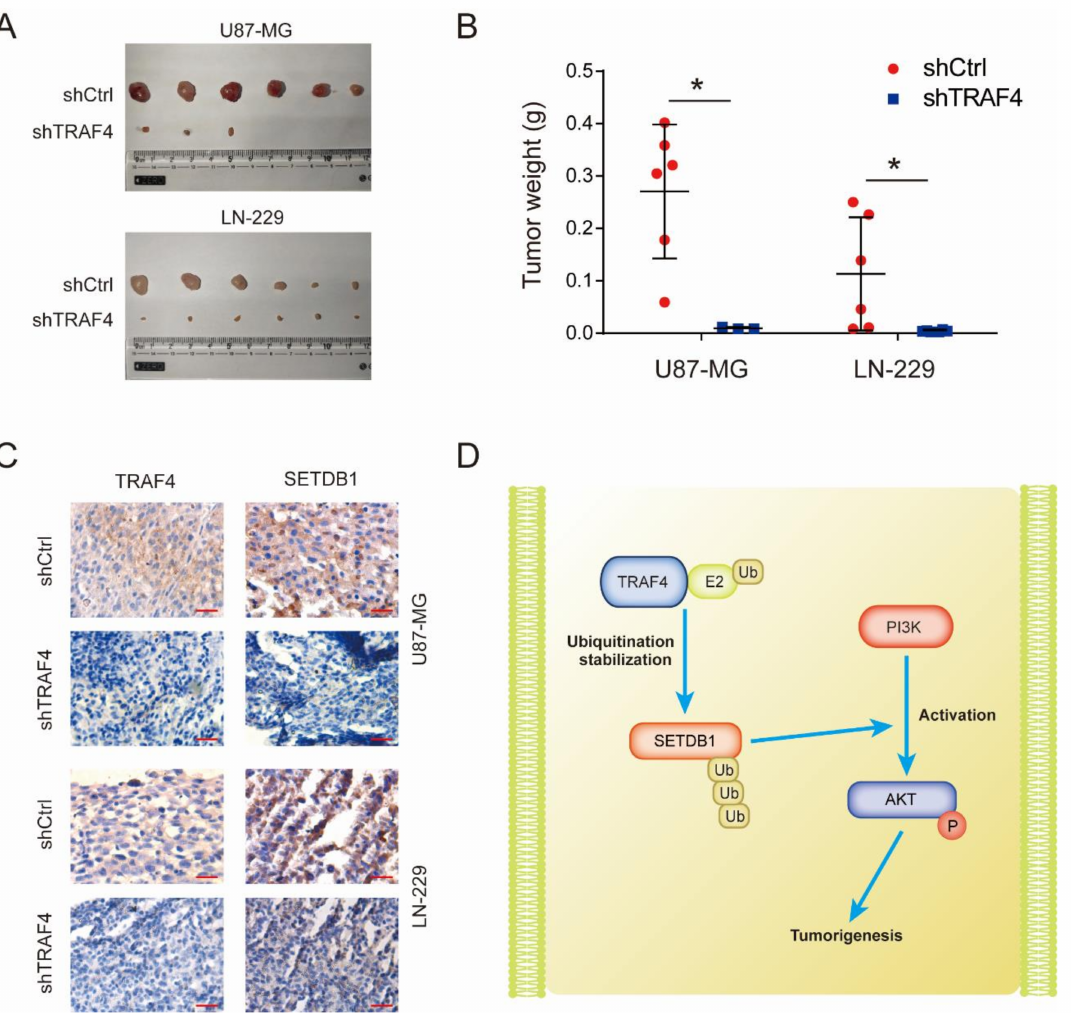
Figure 8. Knockdown of TRAF4 inhibits tumor formation of glioblastoma cells in vivo. ( A ) The in vivo tumorigenic ability of glioblastoma cells was detected by xenograft assay in mice following TRAF4 knockdown. ( B ) Tumor tissue mass in xenograft assay. ( C ) TRAF4 and SETDB1 expression in mice subcutaneous tumor tissues were examined by immunohistochemistry. Scale bars = 20 µ